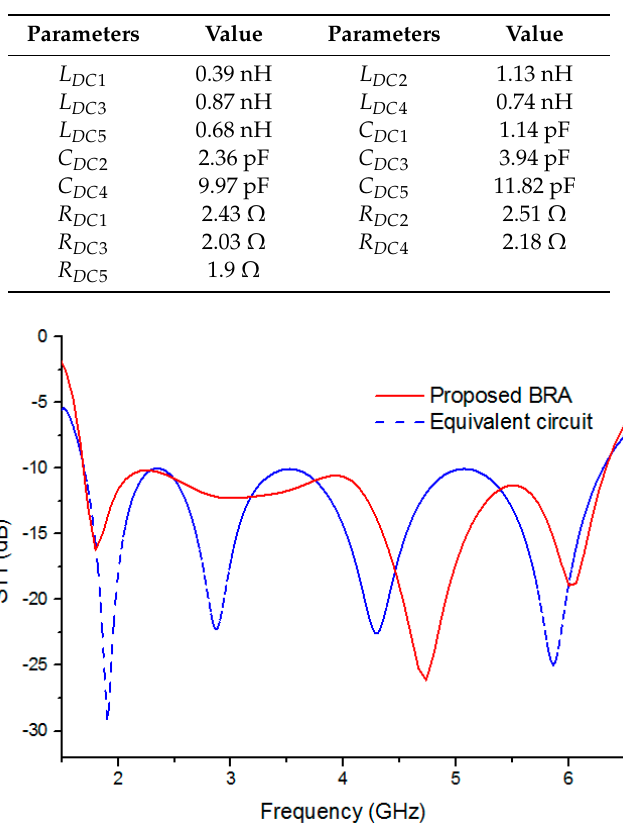
Table 2. Parameters of 5 order L-resonant circuit.